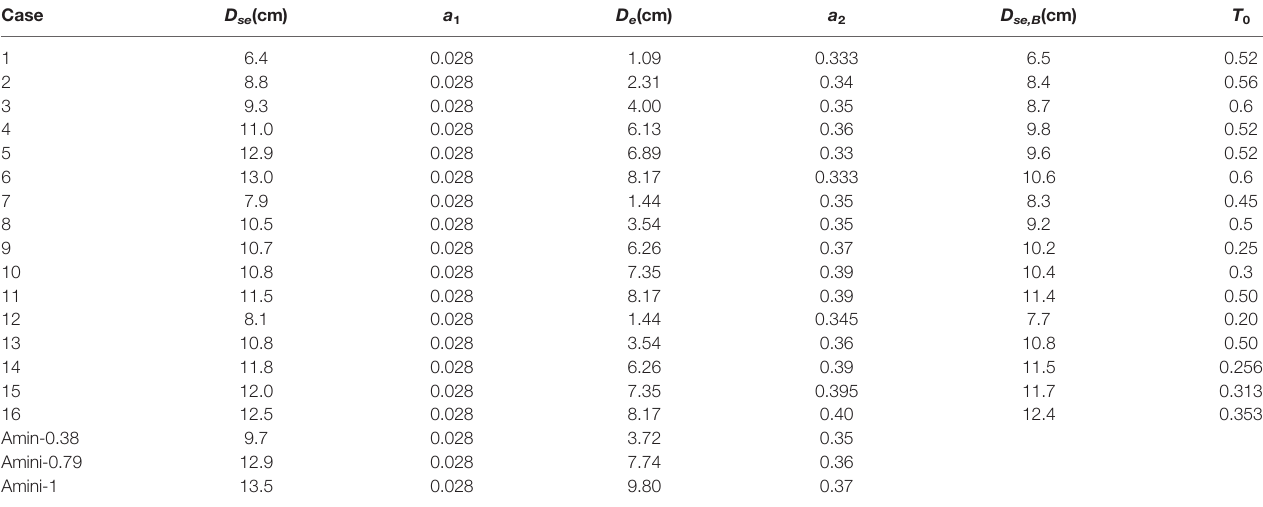
TABLE 2 | Coef fi cients used in the present work and Amini et al.